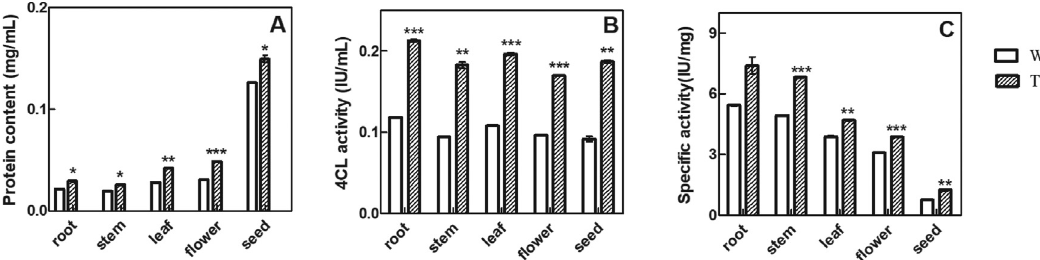
Figure 4 - Analysis of enzyme activity of 4CL in the different tissues of WT and TT. (A) Protein content; (B) enzyme activity; (C) specific activity. The valuesarepresentedasmeans (cid:6) standarddeviations(SD)(n=3).*,**,***indicatesignificantdifferencesincomparisontotheWTplantsat p <0.05,v< 0.01, and p < 0.001, respectively (Student’s t -test).